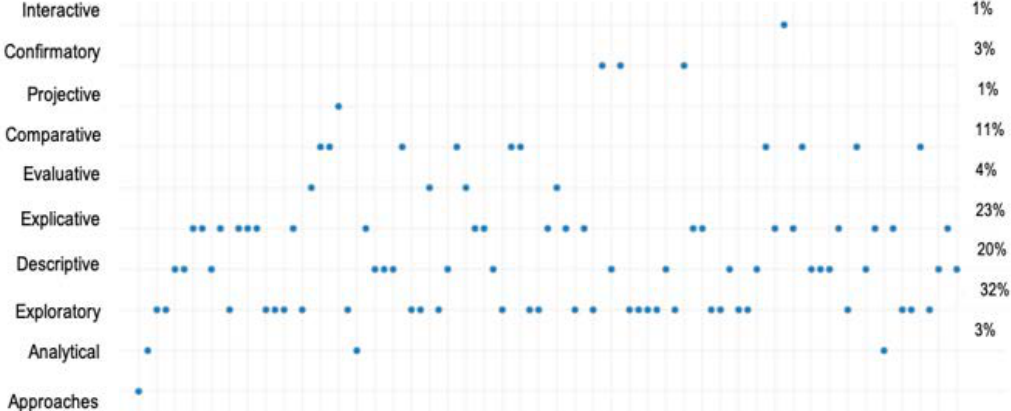
Figure 7. Approaches to educational research used in the